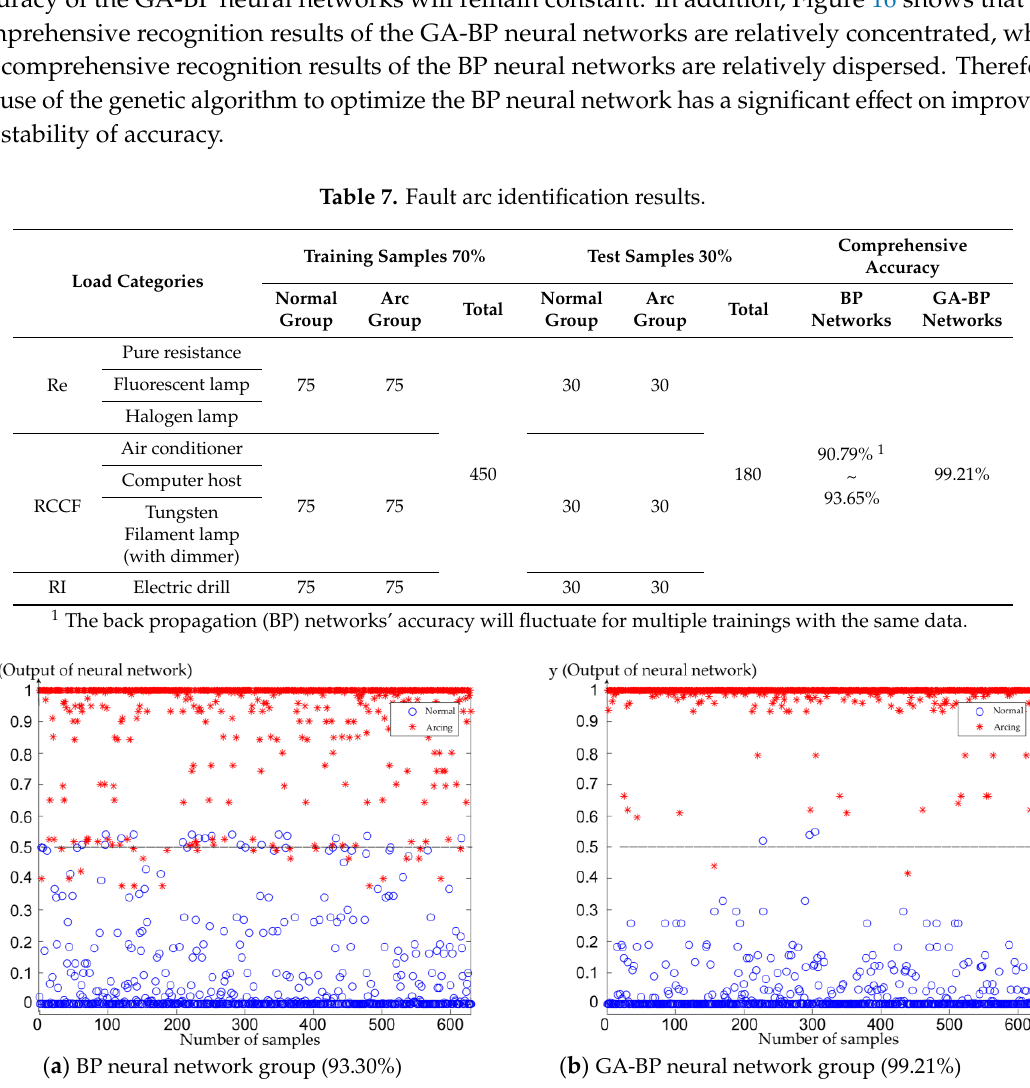
Figure 16. Comparison of effects before and after genetic algorithm (GA) optimization.